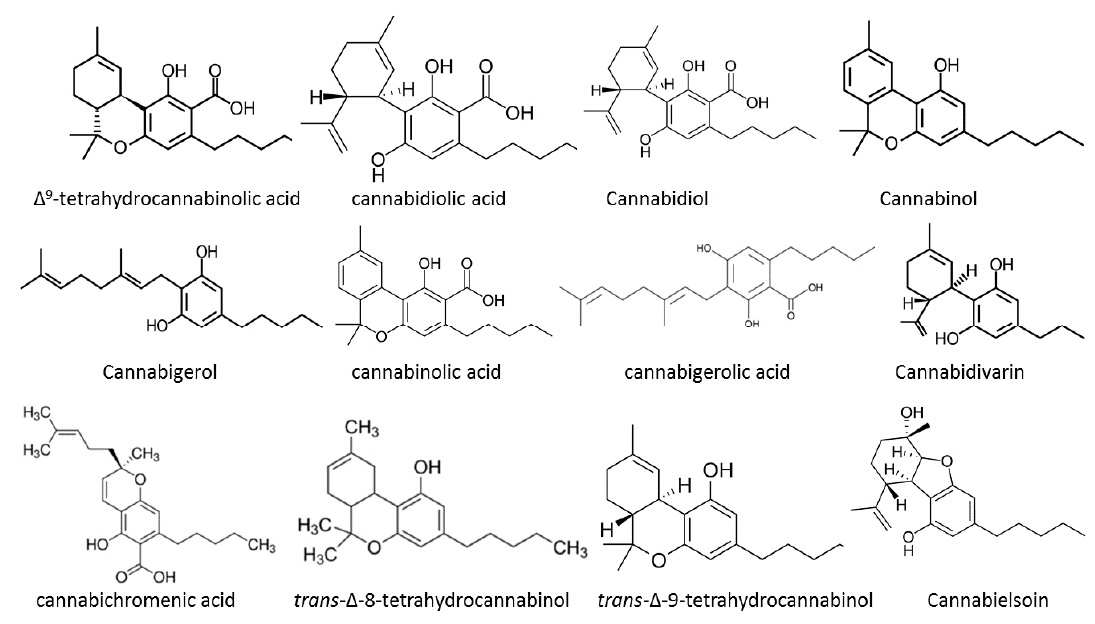
Figure 1. Some natural cannabinoids from the cannabis